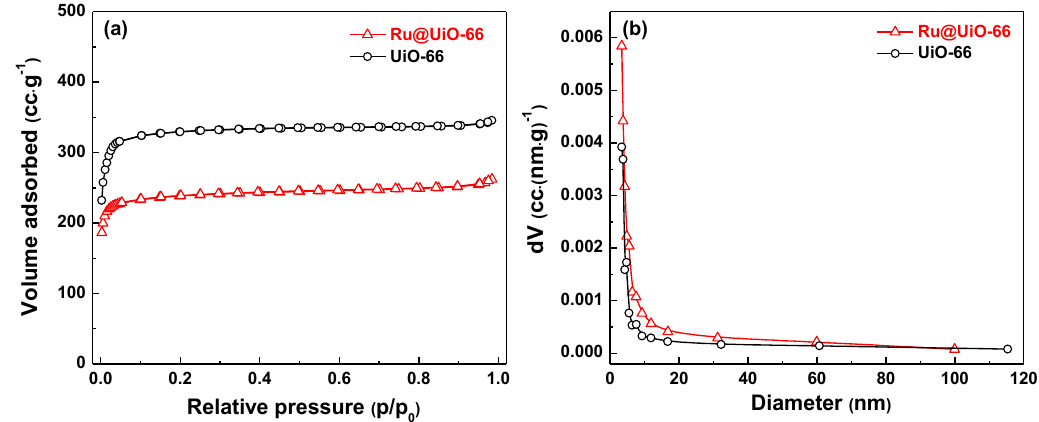
Figure 7. ( a ) Nitrogen adsorption-desorption isotherms and ( b ) the BJH pore size distribution curves of Ru@UiO-66 and UiO-66.